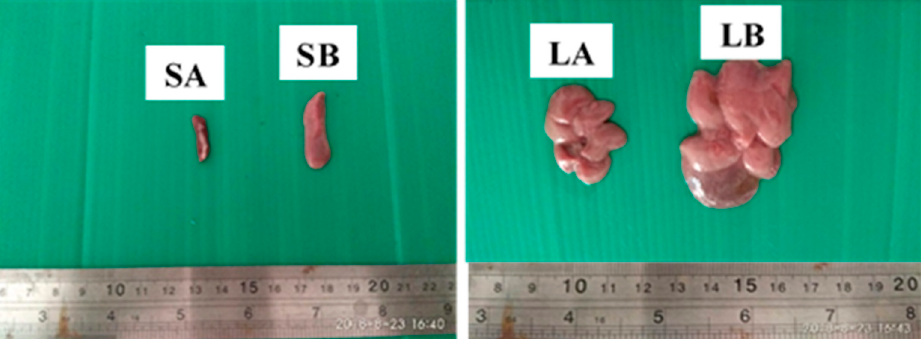
Figure 2. The effect of intraperitoneal (IP) injection of ENU on the gross appearance of spleen and liver of ICR-mice, 12 weeks post injection. Key: SA = normal spleen from a mouse in control group, SB = enlarged spleen from a mouse in ENU treated group showing splenomegaly, LA = normal liver from a mouse in control group, LB = enlarged liver from a mouse in ENU treated group showing hepatomegaly.